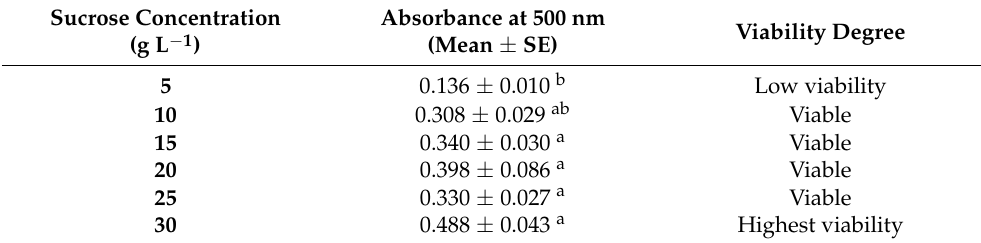
Figure 6. Cell suspension culture of L. schweinfurthii on N2 medium with 30 g L − 1 sucrose after 9 days of culture. Table 3. Cell viability test of L. schweinfurthii cell suspension cultures on MS media with different sucrose concentrations after 2 weeks of